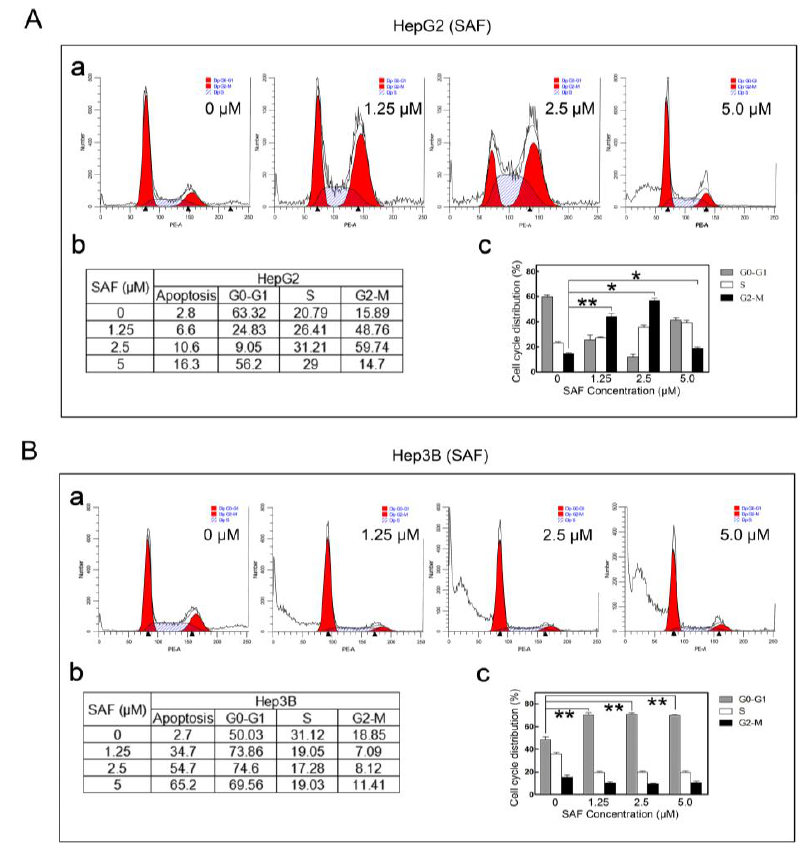
Figure 4. Effect of SAF on the cell cycle. ( A ) Cells were stained with propidium iodide as described in the Materials and Methods and detected by flow cytometry. Cell cycle distribution of SAF-treated or untreated HepG2 cells for 24 h. ( B ) Cell cycle distribution in SAF-treated or untreated Hep3B cells